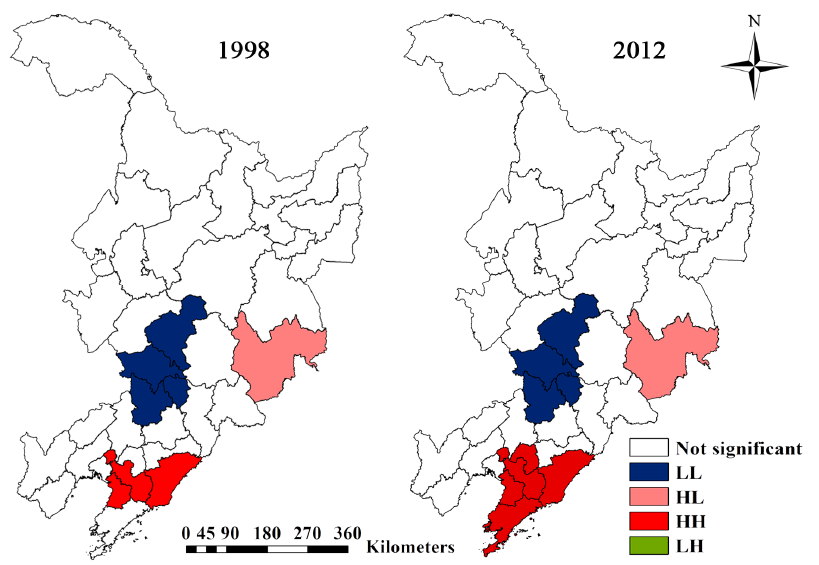
Figure 5. LISA cluster map for WFs of maize production in 1998 and